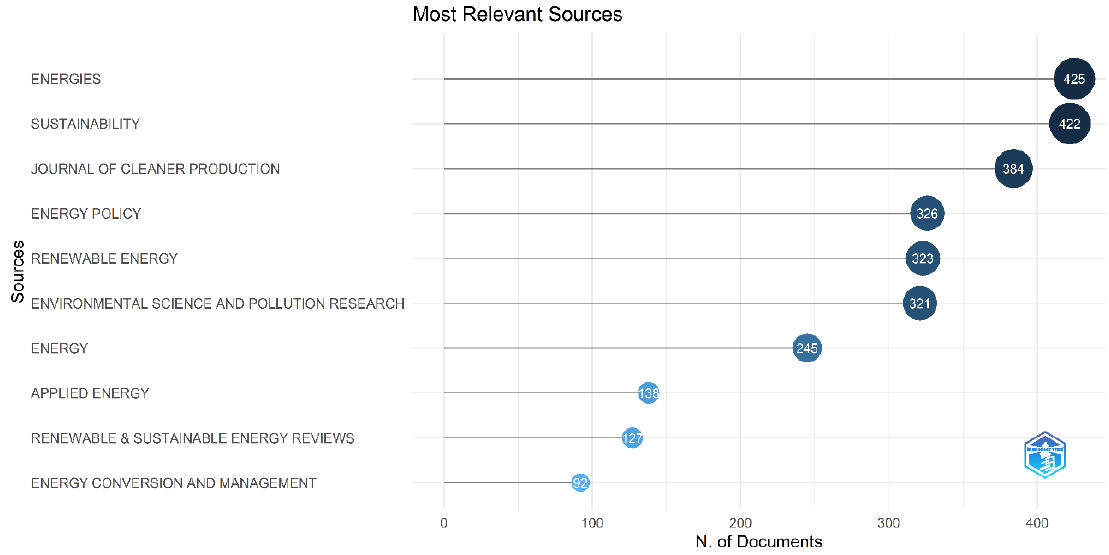
Figure 3. Top 10 most important journals in sustainable development and renewable energy.